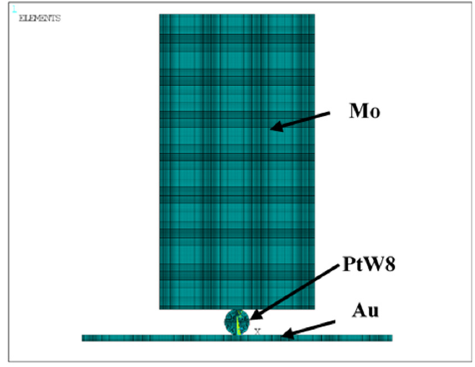
Figure 9. Finite element model of the preloading process.